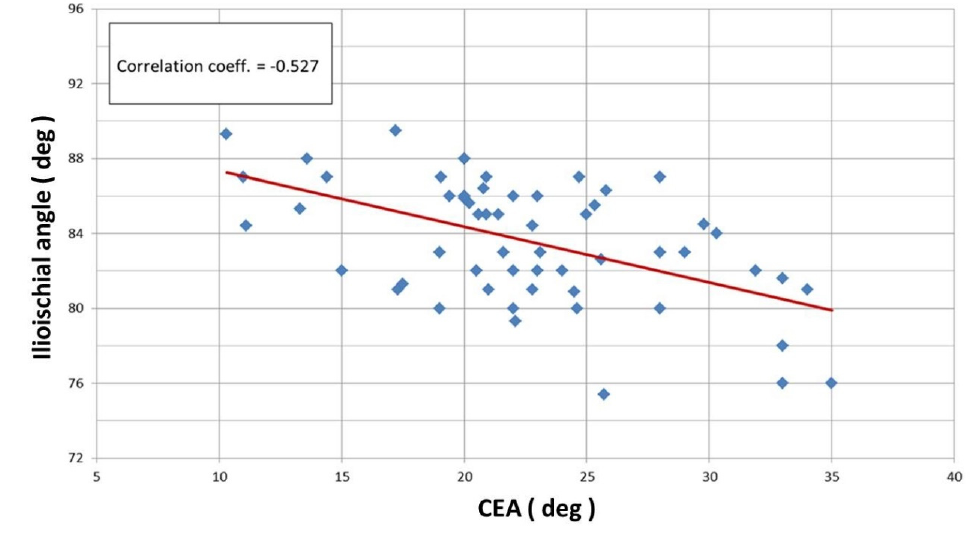
Figure 4. Linear correlation according to Pearson for ilioischial angle and CEA (r = − 0.527).